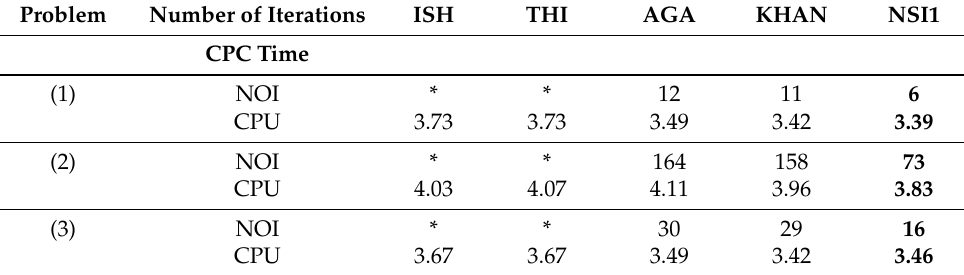
Table 4. Results of comparison of two-step methods on problems in Table